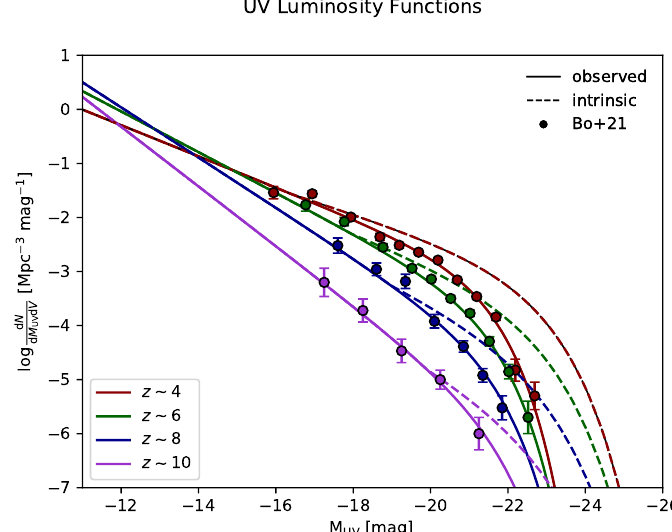
Figure 1. The UV luminosity functions at redshifts z ∼ 4 (red), 6 (green), 8 (blue), and 10 (purple). Data points (circles) and fits are from [70,71]. Solid lines illustrate the observed luminosity func- tions, while dashed lines illustrate the intrinsic ones, after correction for dust extinction via the UV continuum slope according to the procedure by